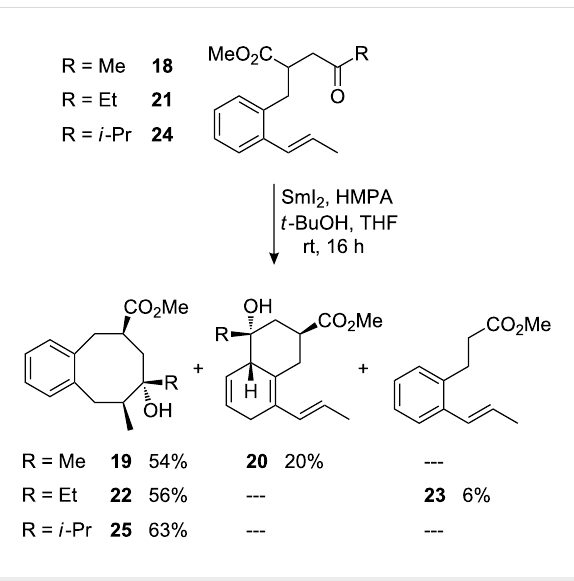
The exclusive cis- selectivity of cyclization, observed in this case, may be attributed to a high level of the steric repulsions between the bulky phenyl group at the alkene moiety and the iso -propyl group at the samarium ketyl in the usually preferred trans -transition structure (compare A , Scheme 6). It is unclear, why the protonation of the samariumorganyl species, which